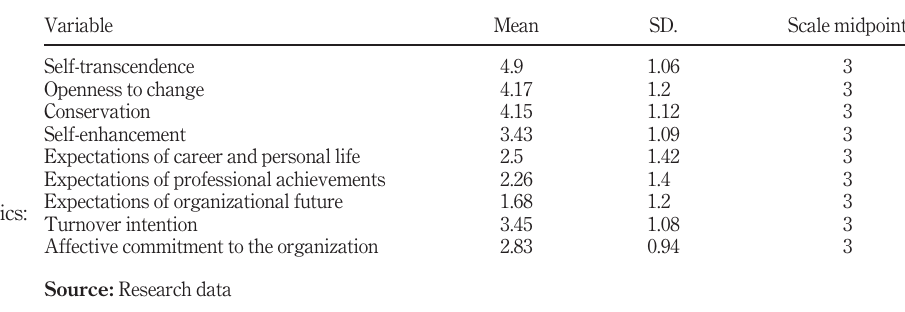
Table II. Descriptive statistics: means, deviations and midpoint ( N =